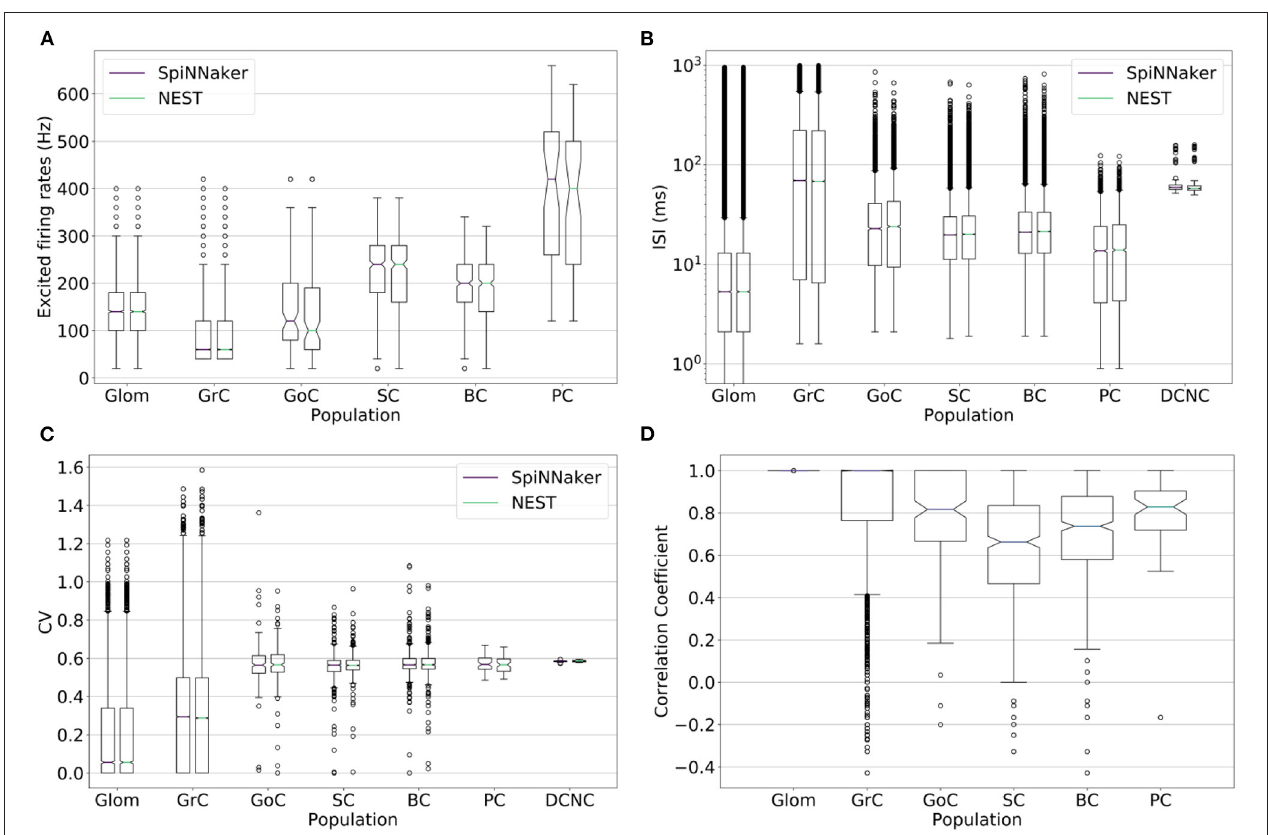
FIGURE 5 | (A) Firing rate, (B) inter-spike interval (ISI), (C) coefficient of variation (CV), and (D) correlation coefficient of the spike trains for each population’s neurons simulated on SpiNNaker (boxplots on the left) and NEST (boxplots on the right). The correlation coefficient is computed over the stimulation period on binned spike times with a bin width of 5 ms. Deep cerebellar nucleus cell (DCNC) is not included in the (A) excited firing rates and (D) correlation coefficient plots as it does not produce any spikes during the stimulation period, which those plots cover. The (B) ISI and (C) CV cover the entire simulation.